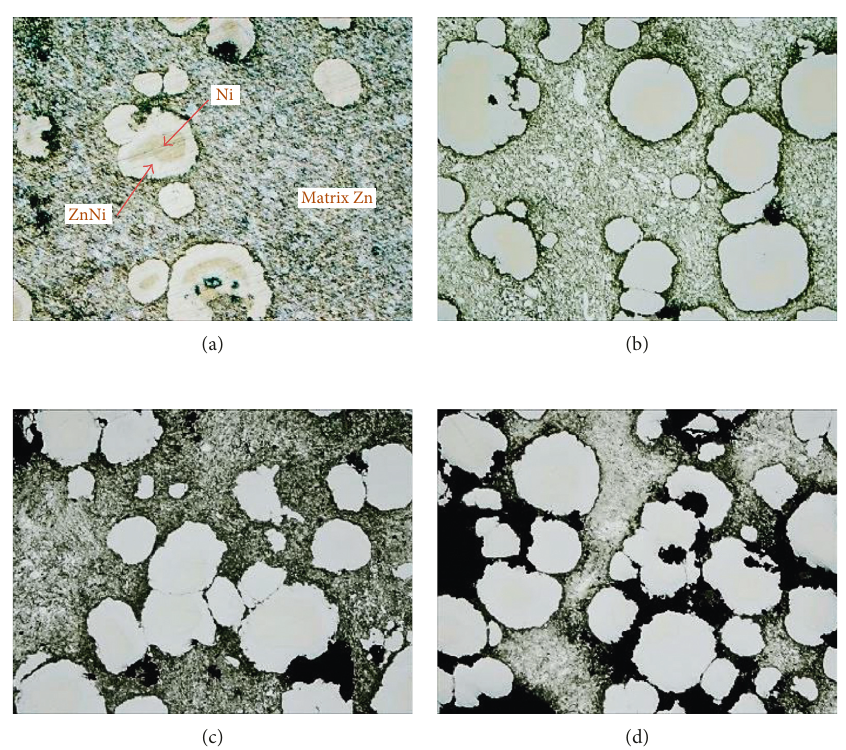
Figure 6: Microstructures obtained by optical microscopy at 20x of the Zn-Ni and (d) Zn-Ni 20 .